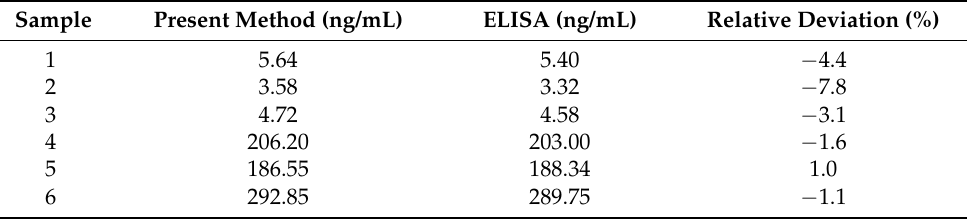
Table 2. Results of CEA in human serum